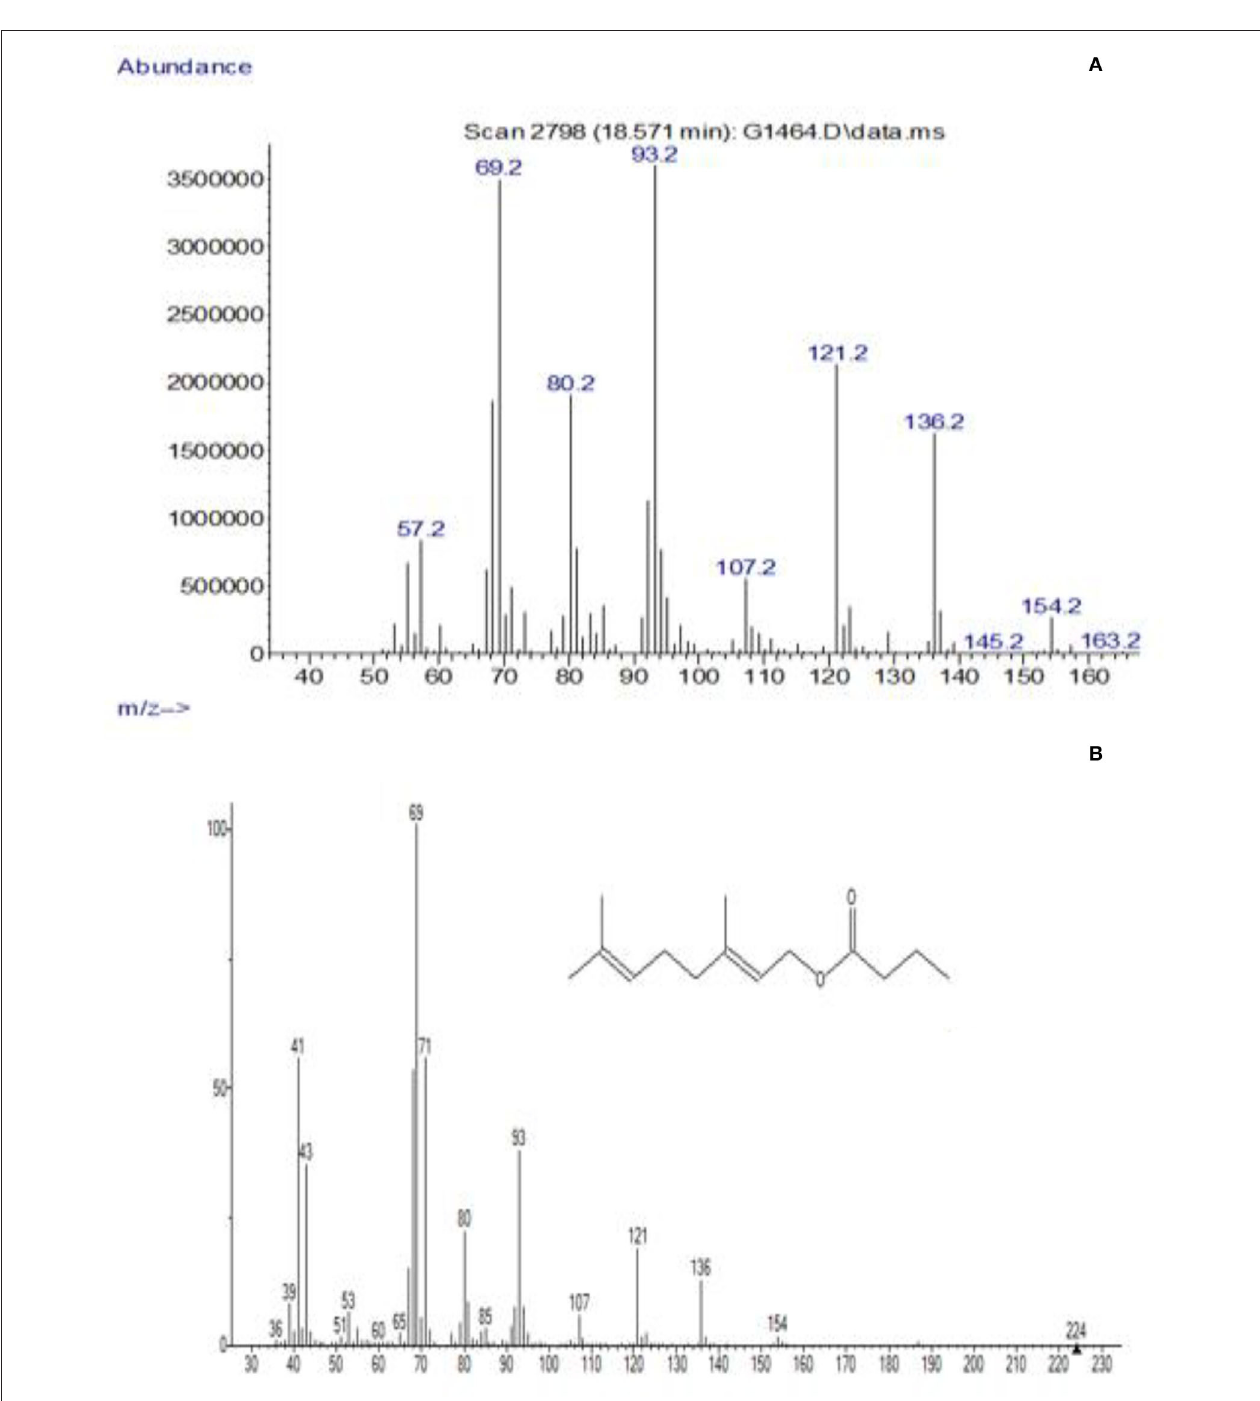
FIGURE 2 | GC-MS spectra of peak (B) identified as geranyl butyrate and its confirmation in this study. (A) Synthesized, (B) MS-library.